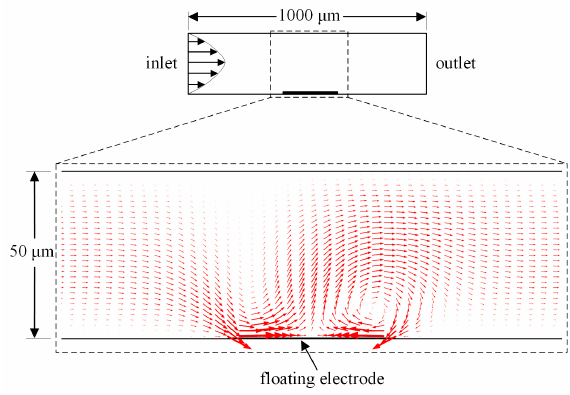
Figure 9. Velocity field distribution in the microchannel subjected to ICEO slippage on the bipolar metal strip when the driving electrode pair was energized with an applied external electrical field magnitude of 8 V. The inlet mean velocity for the parabolic pressure-driven flow was 50 μ m·s − 1 . The schematic is not to scale.